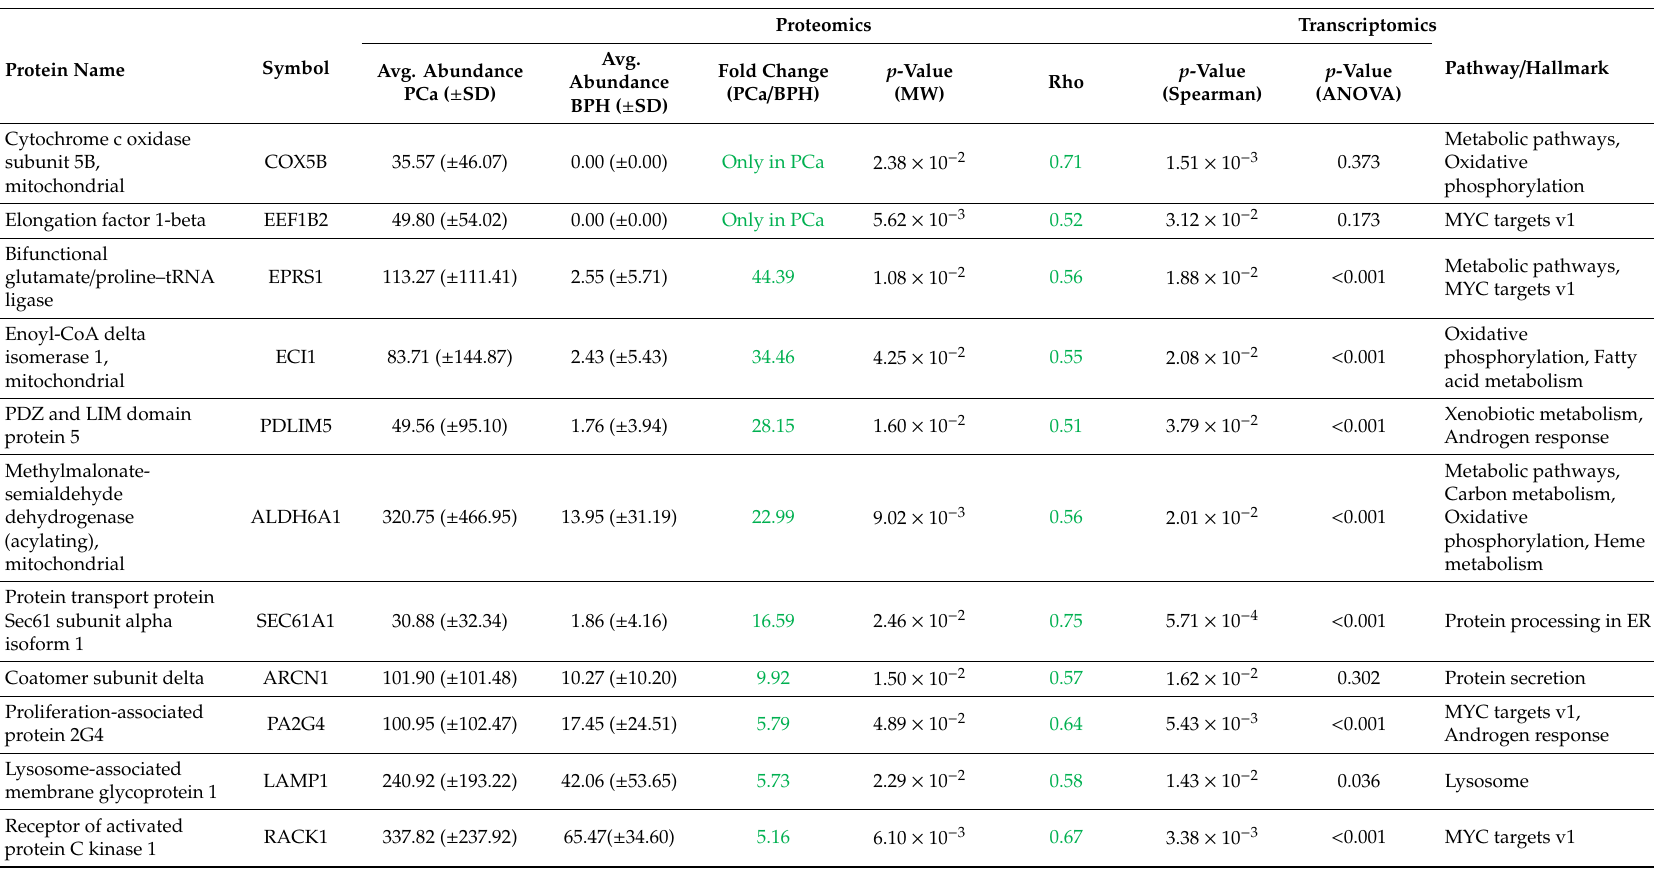
Table 3. List of di ff erentially abundant proteins mapped to enriched pathways / hallmarks and associated with Gleason score